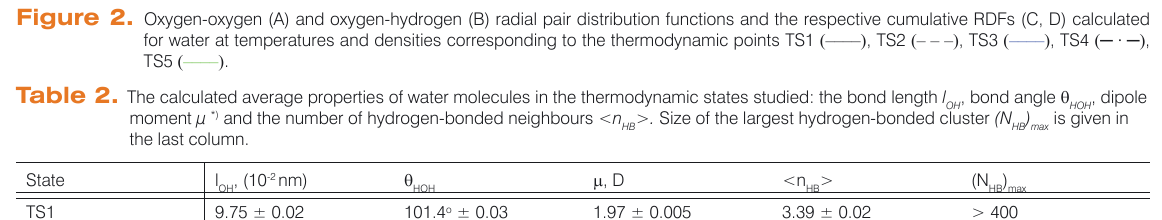
>. Size of the largest hydrogen-bonded cluster (N HB